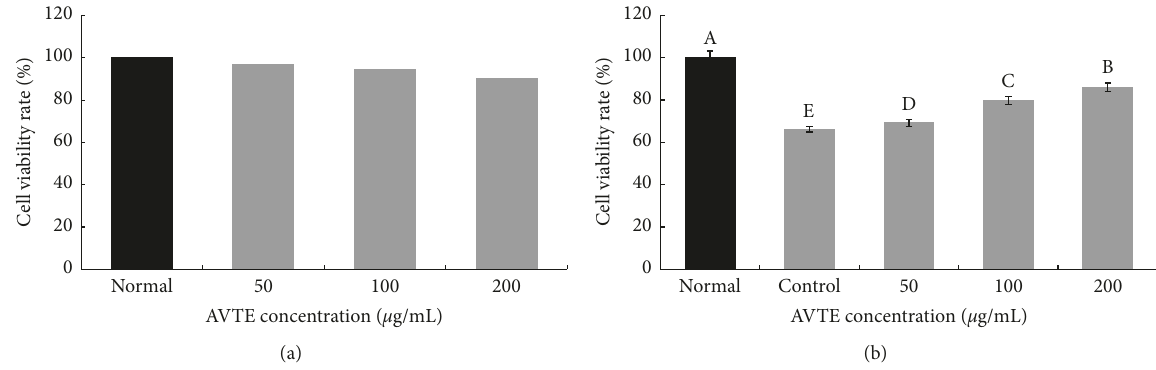
Figure 3: Cell viability of 293T cells was evaluated by using MTT assays. (a) treated with AVTE and (b) treated with AVTE after ad- dition of H 2 O 2 (0.3mmol/L). A–E Mean values with different letters in the same bar graph are significantly different ( P < 0 . 05) according to Duncan’s multiple range